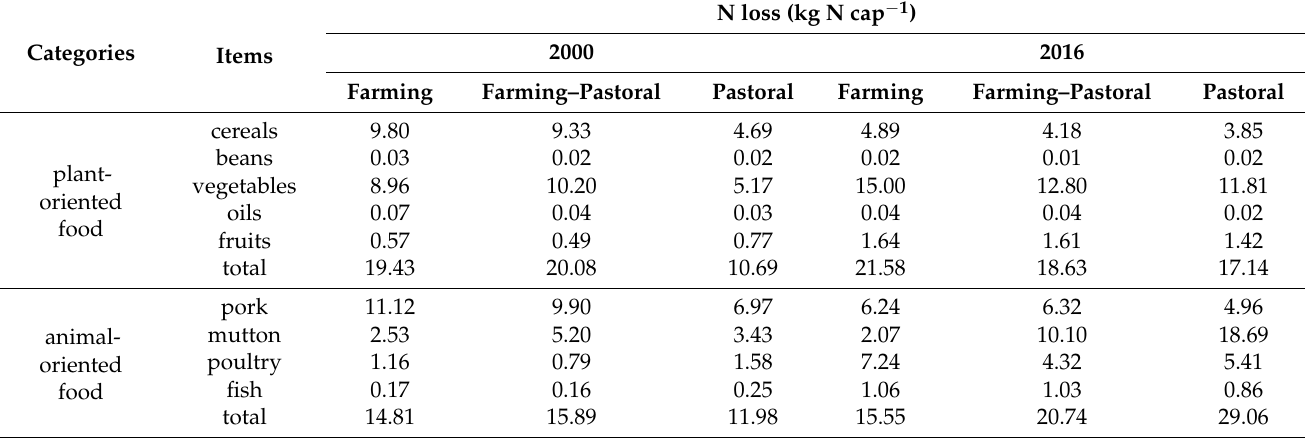
Table 3. Comparison of the N loss from different food species in the three regions in 2000 and